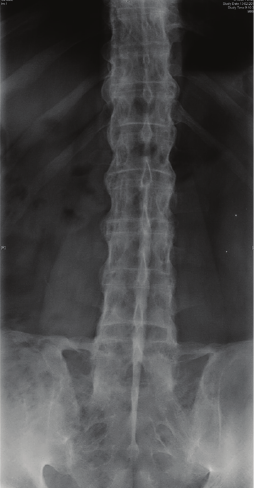
Figure 1: Lumbar spine and iliolumbar ligament